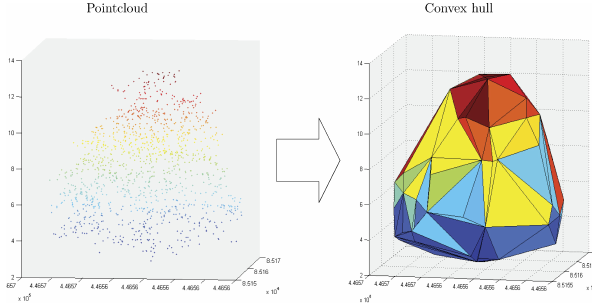
Figure 3: The shape of the reconstructed trees is represented by their convex hulls